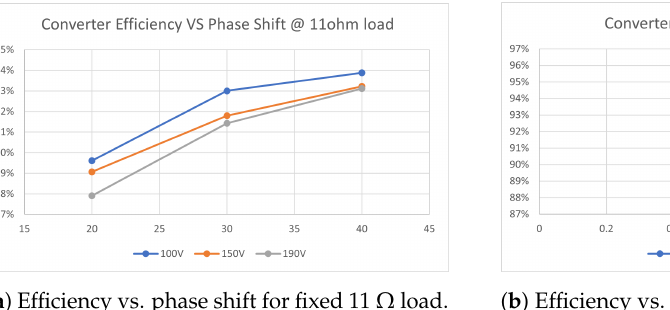
Figure 19. Efficiency results for V in = 100 V,150 V,190 V.